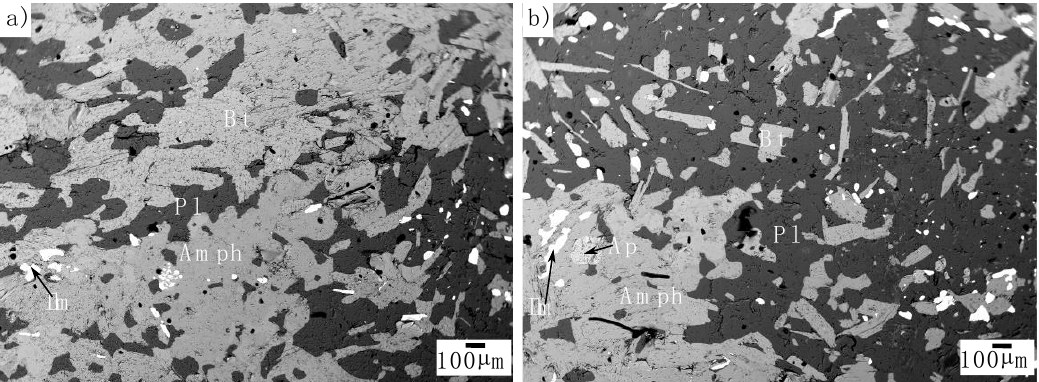
Figure 4. Back-Scattered Electron (BSE) images of the lamprophyre dyke sample, showing the biotite, amphibole, plagioclase, and ilmenite assemblage ( a ), and the biotite, amphibole, plagioclase, and ilmenite assemblage with apatite inclusions in amphibole ( b ). Bt—Biotite; Ilm—Ilmenite; Pl— Plagioclase; Amph—Amphibole; Ap—Apatite.